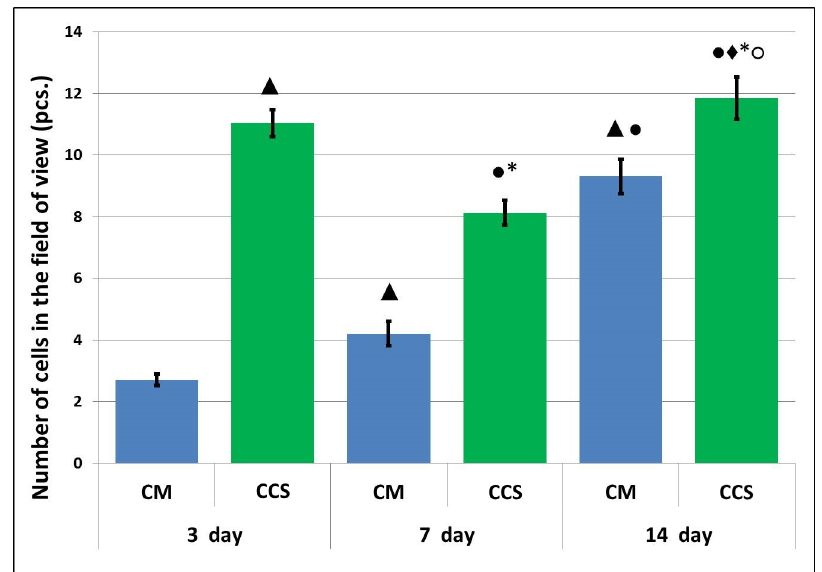
Figure 11. Number of cells per field of view (transmission microscopy). Note: CM—collagen matrix with MSC, CCS —cell-containing scaffold; ▲ — р < 0.05 with 3-day CM; ● — р < 0.05 with 7-day CM;